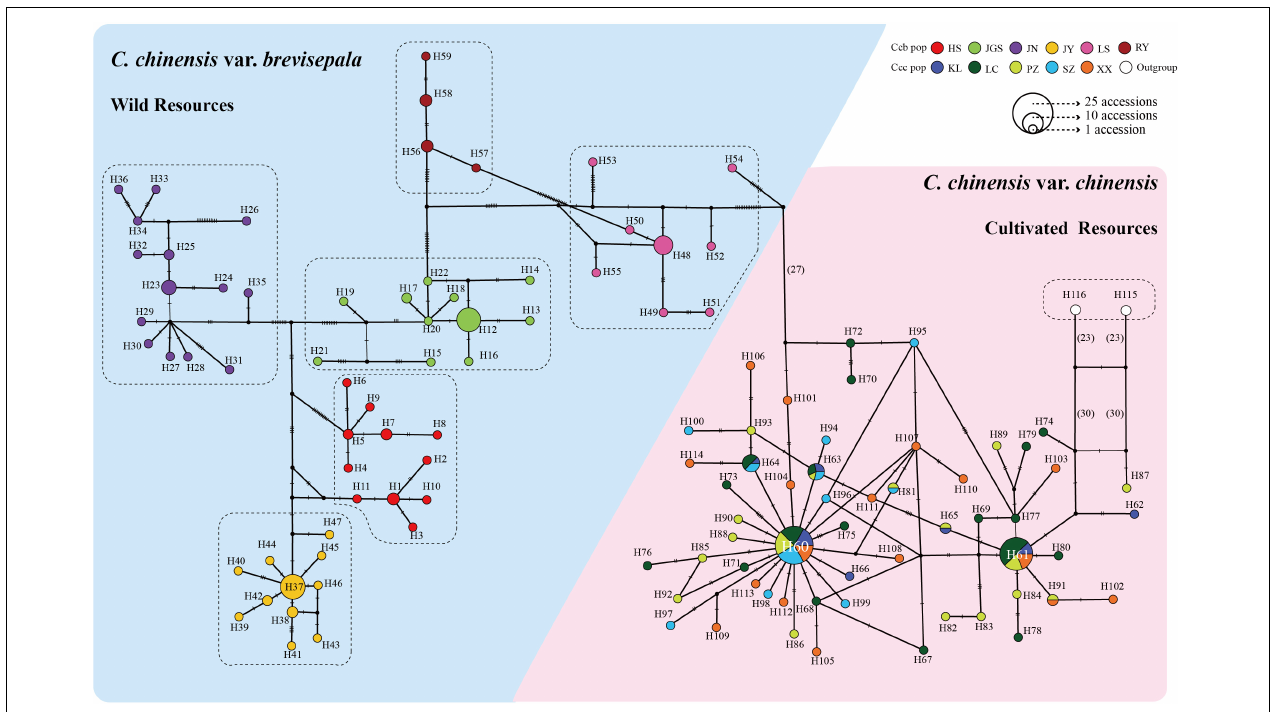
FIGURE 6 | TCS network for all 227 accessions based on 25,197 cpDNA fragments. Circle size is proportional to haplotype frequency. Different colors indicate different subpopulations from different distributions, and missing haplotypes are indicated by black dots. Mutational steps are indicated by hatchures (if the number of steps is less than 20) and number (if the number of steps is greater than